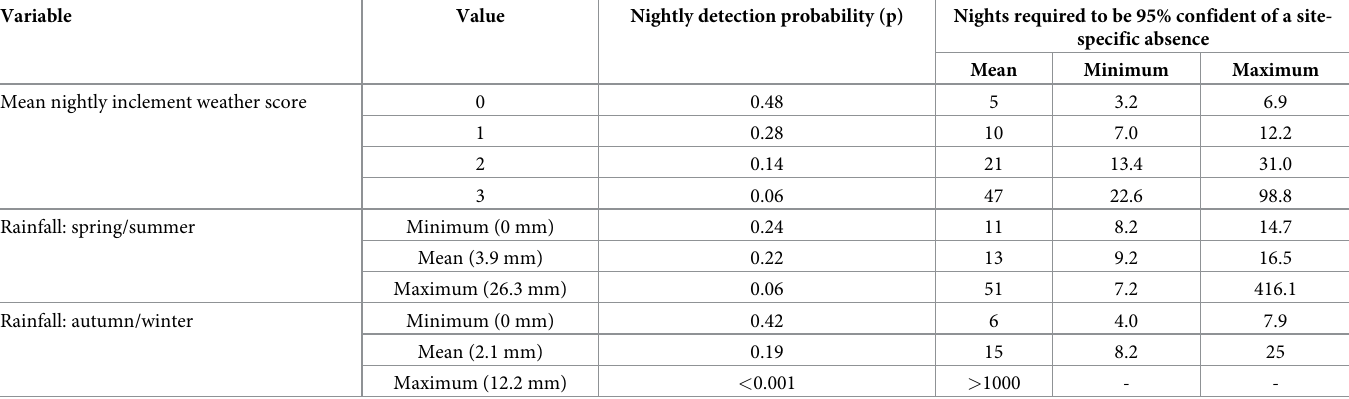
Table 2. The number of survey nights required to be 95% confident of a site-specific absence of Yellow-bellied Gliders, under varying conditions of season, inclem- ent weather score and rainfall. Variable Value Nightly detection probability (p)